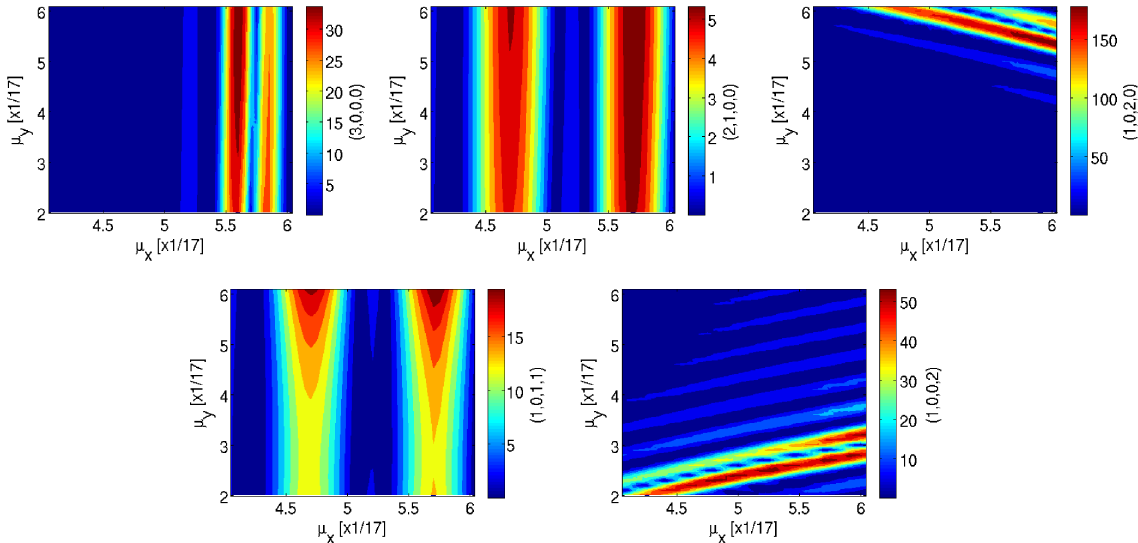
FIG. 9. Horizontal and vertical phase advances of the PDR TME cell, parametrized with the third order Hamiltonian